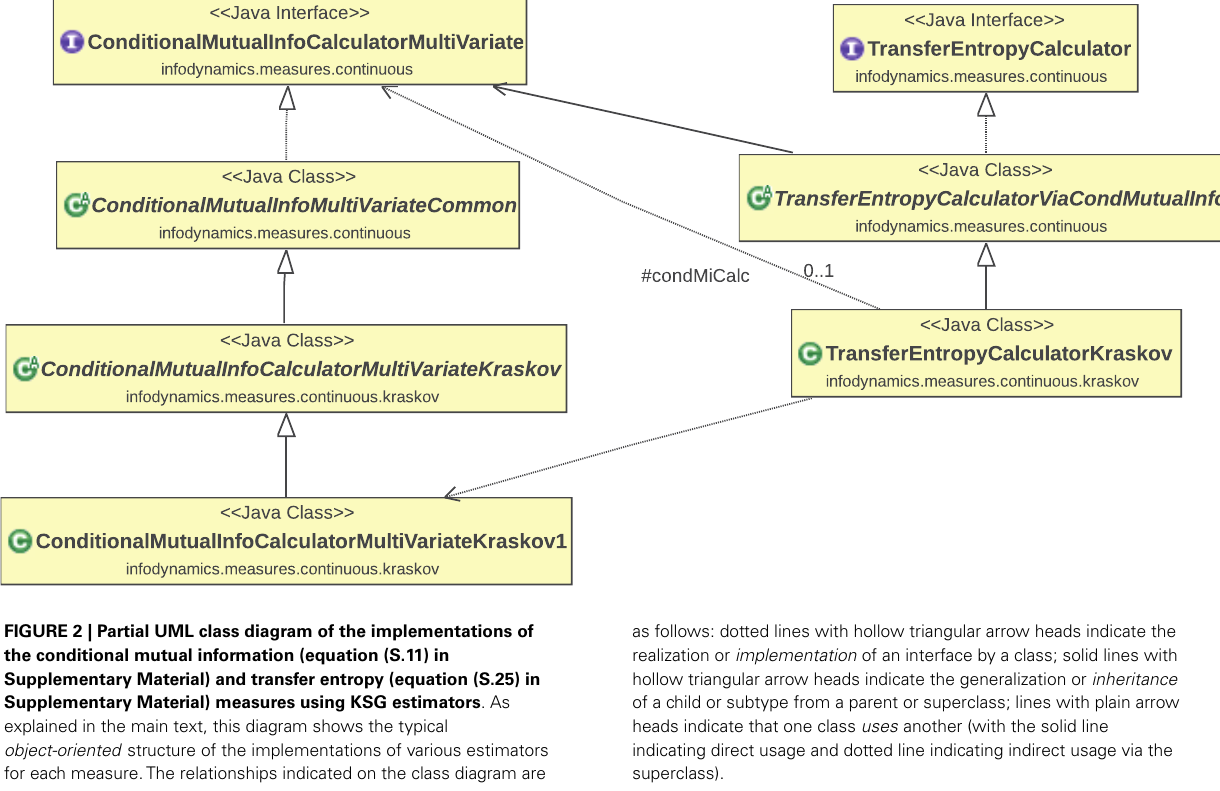
as follows: dotted lines with hollow triangular arrow heads indicate the realization or implementation of an interface by a class; solid lines with hollow triangular arrow heads indicate the generalization or inheritance of a child or subtype from a parent or superclass; lines with plain arrow heads indicate that one class uses another (with the solid line indicating direct usage and dotted line indicating indirect usage via the